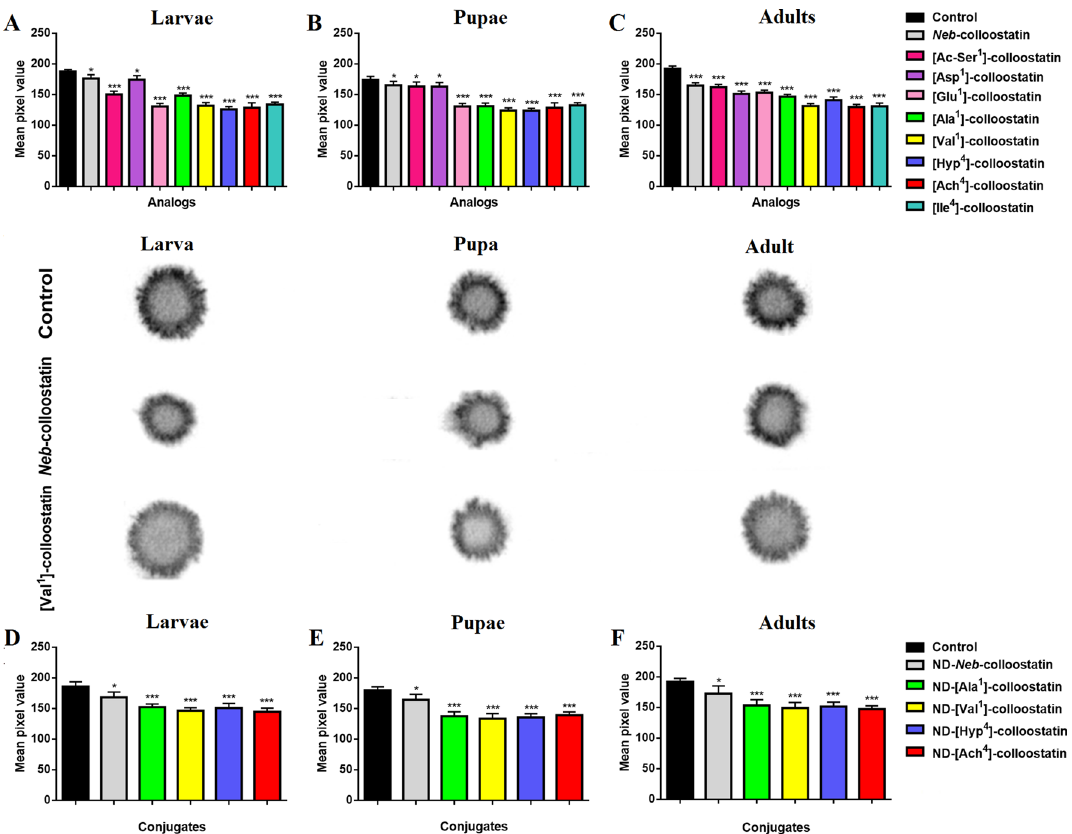
Figure 4. Phenoloxidase activity in bacteria-infected T. molitor larvae ( A , D ), pupae ( B , E ) and adults ( C , F ) following injections of Neb -colloostatin or one of its analog at doses of 2 ng of peptide per insect ( A – C ) and following topical applications of ND- Neb -colloostatin or conjugates of NDs and the most potent analogs at doses of approximately 4.15 µg of NDs and 0.85 µg of peptide per insect ( D – F ). The values shown are means ± S.D. The results significantly different from those of the control group are indicated: p < 0.005 (***). Examples of melanized spots produced by 1-µl aliquots of hemolymph taken from saline-, Neb -colloostatin- or [Val 1 ]-colloostatin-injected larva, pupa and adult of T . or apoptotic body. During the immune recognition of pathogens by hemocytes, the hemocytes recognize com- plementary chemical signals from the pathogens, such as fungal-specific β-1,3 glucans, bacterial peptidoglycans and lipopolysaccharides, and the nucleic acids of bacteria and viruses 44 . The engulfment of a pathogen or abiotic particle by a phagocyte depends on the local polymerization of actin and the formation of F-actin microfilaments at the remodeling site of a fragment of the cell membrane, which then surrounds the absorbed object and forms a phagosome 45 . At the next stage of phagocytosis, pathogens are killed by reactive oxygen species (ROS), and the enzymatic degradation of pathogens takes place in phagosomes with the participation of enzymes such as V-ATPase, DNase and cathepsin 46 . It has been suggested that the hemocytes that effectively remove pathogens from the insect’s hemolymph are plasmocytes 47 . However, our previous studies indicate that, in T. molitor, the ability to phagocytose latex beads is demonstrated not only by plasmatocytes but also by granulocytes and even prohemocytes (unpublished results). Regarding nodule formation, it involves a large number of hemocytes in the isolation and inactivation of the invading pathogens 44 . Granulocytes are responsible for the immobilization of pathogens in the hemolymph and the chemotaxis of plasmatocytes to the site of infection. Granulocytes release the content of their granules into the insect’s hemolymph, and together with plasmatocytes, they form a multilayered nodule that isolates patho- gens from other host cells 48 . During nodule formation, remodeling of the hemocytes in the cytoskeleton occurs because the hemocytes that were previously freely circulating in the insect’s hemolymph must become adhesive cells at the site of infection. Hemocytes are also responsible for the synthesis and release of prophenyloxidase into the hemolymph of the insect, which, after activation in the hemolymph by serine proteases, is involved not only in the recognition, opsonization and killing of pathogens but also in the coagulation of the hemolymph, wound healing, and sealing of nodules and capsules that isolate pathogens from other cells of the insect 44,47 . The ability of insects to maintain an appropriate number of hemocytes in the hemolymph is therefore of key importance for the resistance of insects to pathogens and thus for their viability and survival. As shown in Fig. 1, all tested analogs of Neb -colloostatin caused significant decreases in the number of hemocytes circulating in the hemolymph of T. molitor larvae, pupae and adults compared to the number of hemocytes observed in the control groups. The findings of this study showed that the analogs [Ala 1 ]-, [Val 1 ]-,